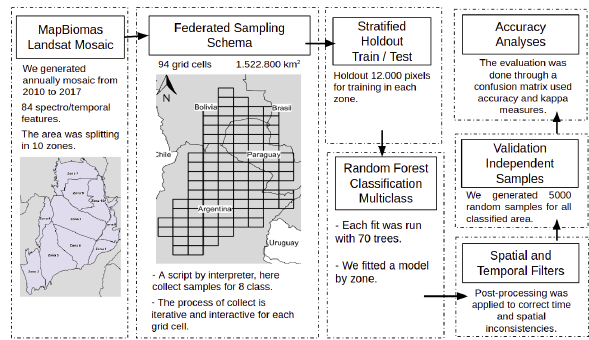
Figure 1. Methodological steps of Collection 1 to implement MapBiomas algorithms in the Google Earth Engine. Level 1 Level 2 1. Natural Terrestrial